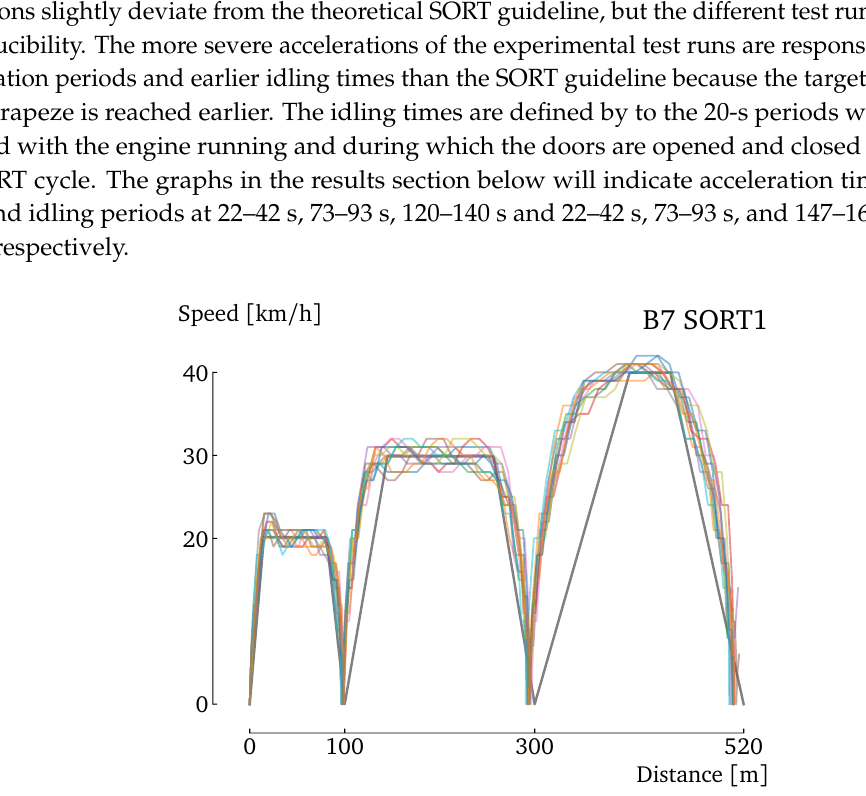
Figure 3. The velocity profile of the repetitions (individual lines on the figure) is close to the theoretical SORT guideline except for deviations at the nonlinear velocity changes of the